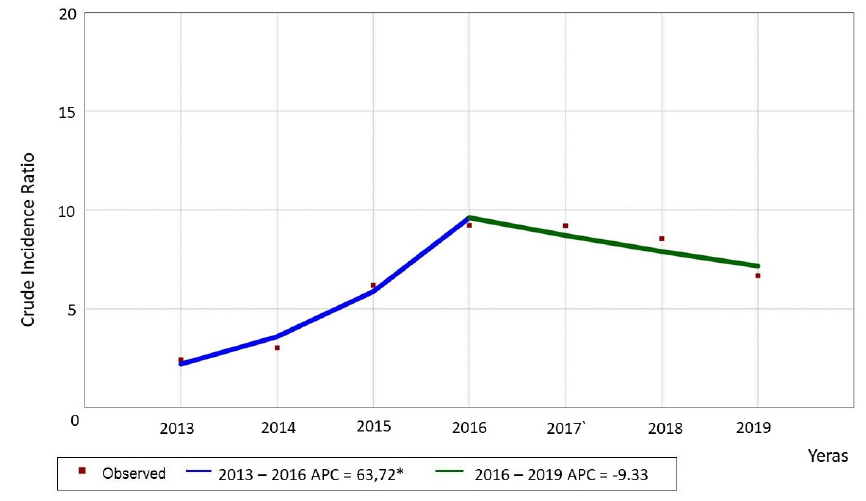
Figure 2. Trend of patient falls (Crude incidence ratio [cIR] per 1000 patients-beds) for all the departments. * please pay attention to a different scale. Different changes in fall incidence were observed in the analyzed wards. The highest incidence of falls was reported in the rehabilitation ward, where the maximum cIR of 41.06